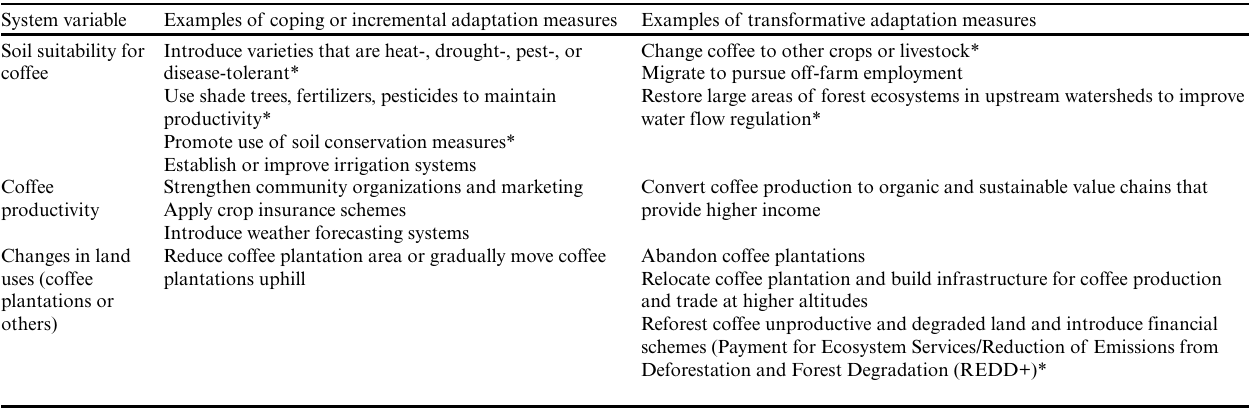
Table 5 . Overview of farmer adaptation strategies to climate change impacts on coffee production. Adaptation strategies are characterized by the type of adaptation measure (coping or incremental, or transformative) and whether they are ecosystem-based adaptation (*).